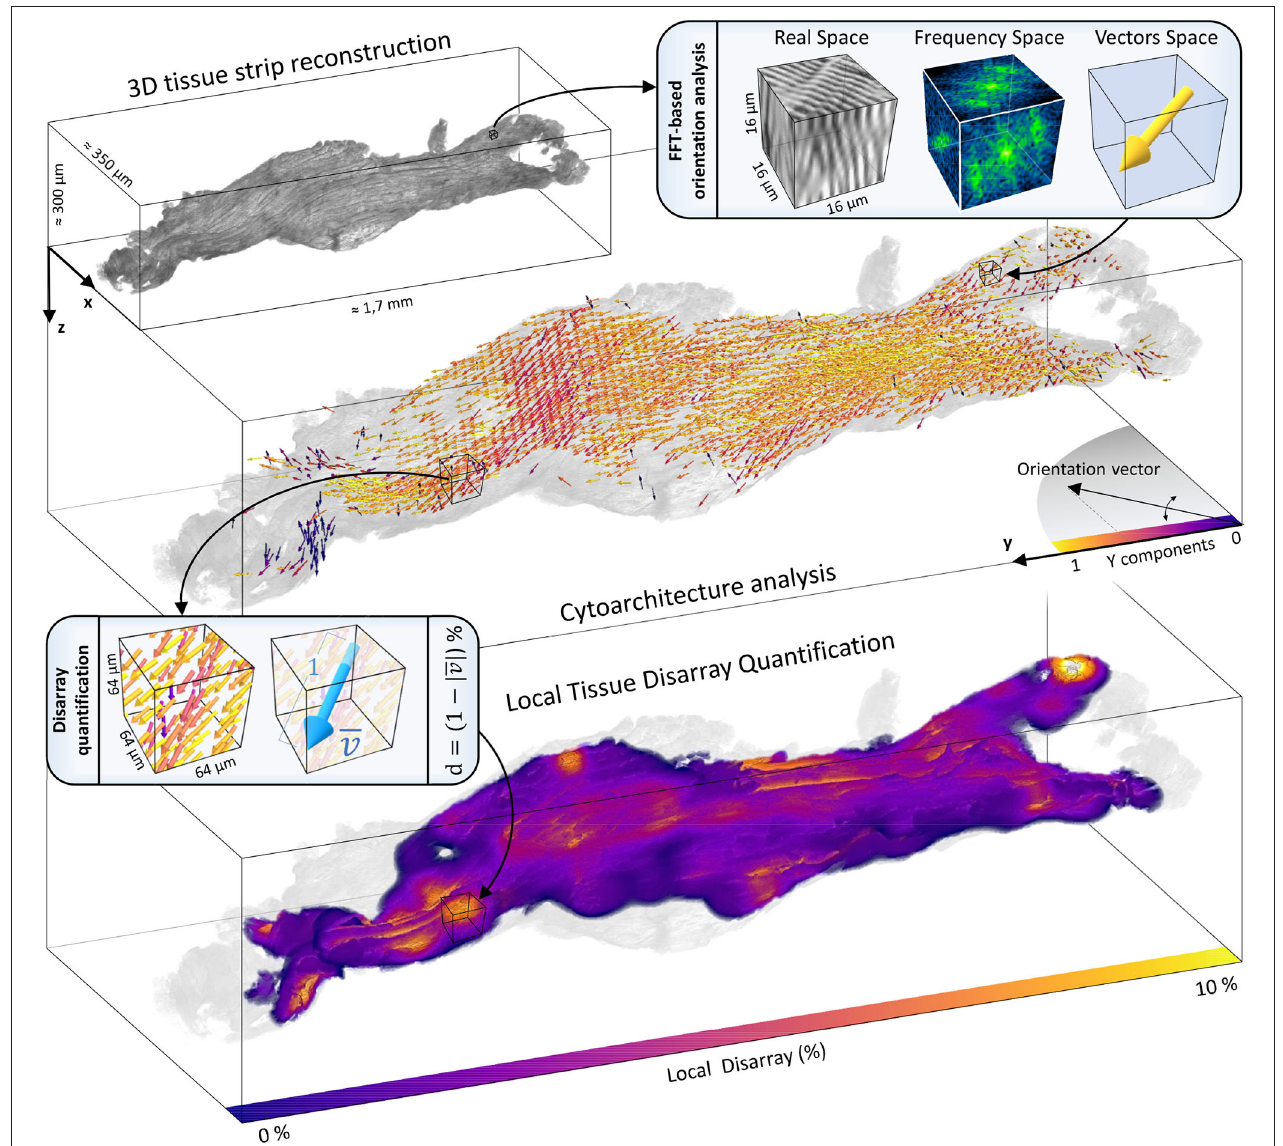
FIGURE 7 | Cytoarchitecture reconstruction and disarray mapping. The 3D reconstruction of a representative strip (IVS1) is shown. The volume is virtually dissected in chunks of 16 16 16 µ m. The FFT-based analysis is applied to each portion to extract the local fiber orientation. The entire cytoarchitecture is collected and × × represented in a vector space. Vectors color represents the alignment degree with the main axis of force production ( Y ). Then, local cellular disarray d is evaluated with a pre-defined resolution (here of 64 64 64 µ m), and a 3D map of the cell misalignment is created smoothing the results with a gaussian kernel with σ × ×